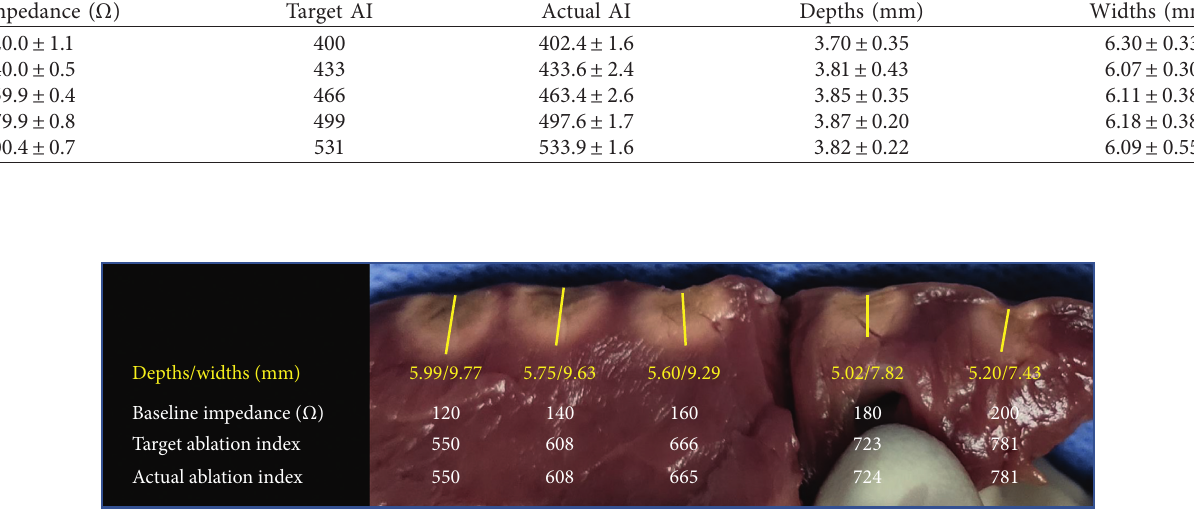
Figure 6: Baseline impedance and AI values in the high AI groups and the corresponding lesions created under these settings. Table 3: The lesion depths in the high AI groups and the P values between the experimental groups and control group. 550/120 Ω